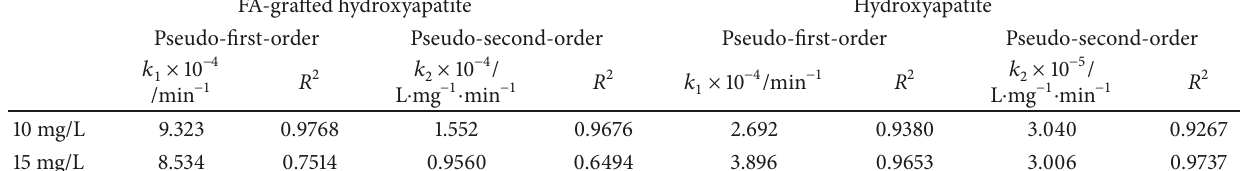
Table 1: The fitted results of k 1 and k 2 and correlation coefficients for two models. FA-grafted hydroxyapatite Hydroxyapatite Pseudo-first-order Pseudo-second-order Pseudo-first-order